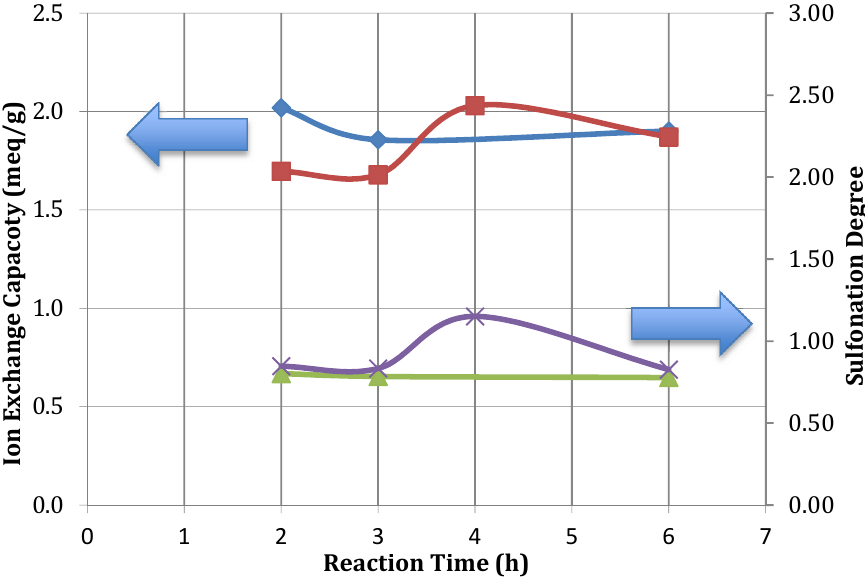
Figure 3. SPEEK IEC and DS various reaction times ( ○ , 50 ° C IEC; □ , 60 ° C IEC; ∆ , 50 ° C SD; ×, 60 ° C